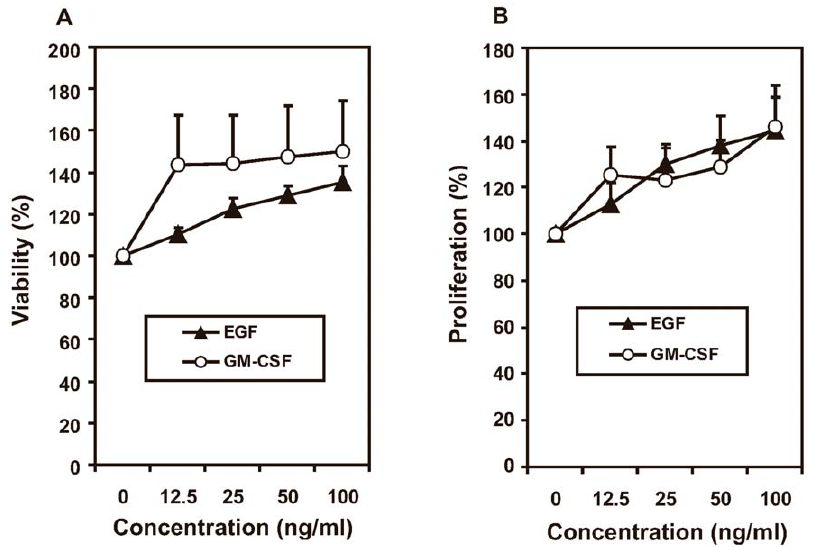
Figure 5. GM-CSF and EGF increase viability and proliferation of B6Tert-1 cells. B6Tert-1 cells were seeded in 96-well plates and treated with GM-CSF or EGF at different concentrations as indicated in FD medium for 24 h. The data are expressed as the percentage of treated/untreated. Each data point represents mean 6 SEM (n=7).